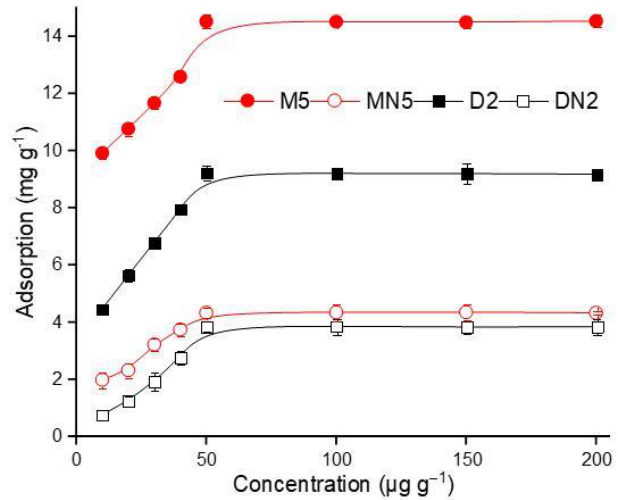
Figure 7. Isothermal binding of the polymers. Table 3. Pseudo-second-order, Langmuir, and Freundlich model parameters for the binding of ABM on MIPs and NIPs.